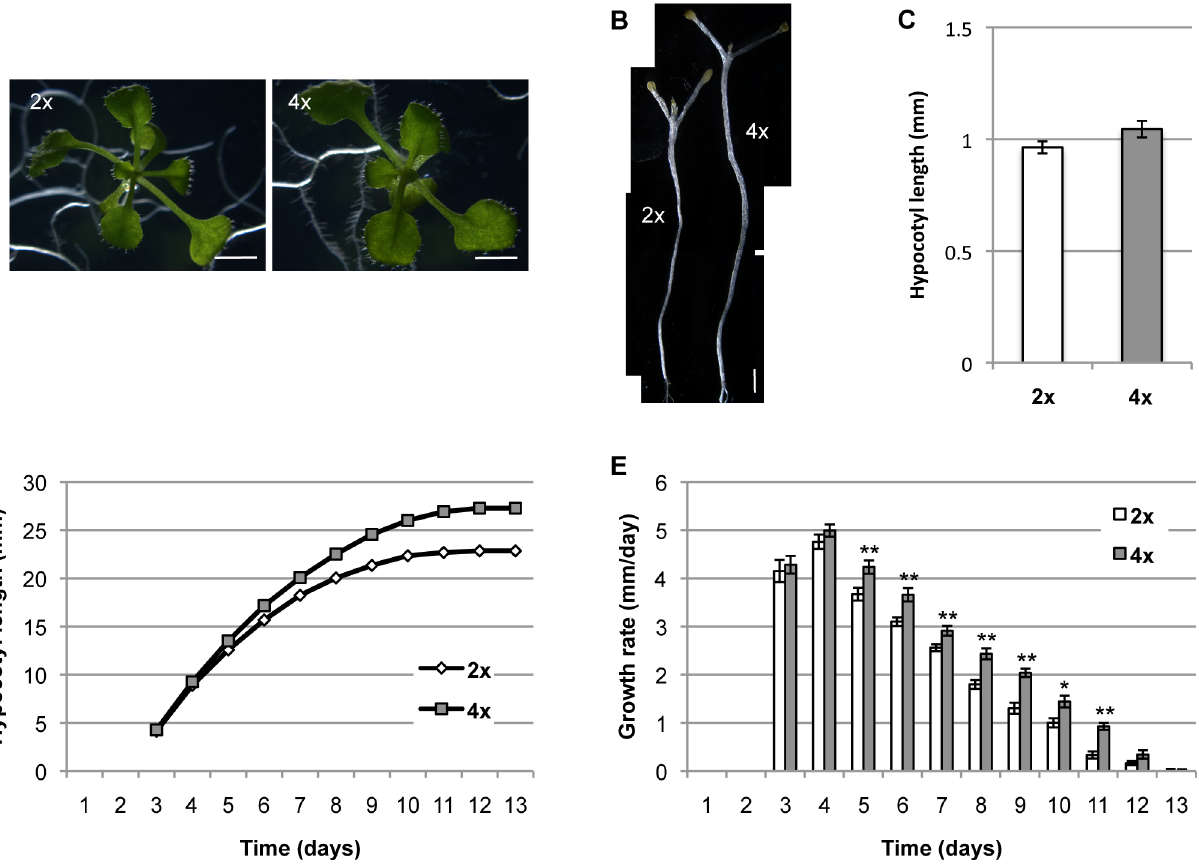
Fig 1. Growth of diploid and tetraploid hypocotyls. (A, B) Morphology of 13-day-old light- (A) and dark-grown (B) seedlings. Bars = 2 mm. (C) Hypocotyl lengths of 13-day-old light-grown seedlings. Error bars represent SE (n = 20). (D, E) Hypocotyl lengths (D) and growth rates (E) of dark-grown seedlings. Error bars represent SE (n = 15). Where absent, error bars are smaller than the symbols. Asterisks indicate a significant difference between the diploid and tetraploid plants ( ** p < 0.01, * p < 0.05, Student ’ s t -test). 2x, diploid plants; 4x, tetraploid plants.